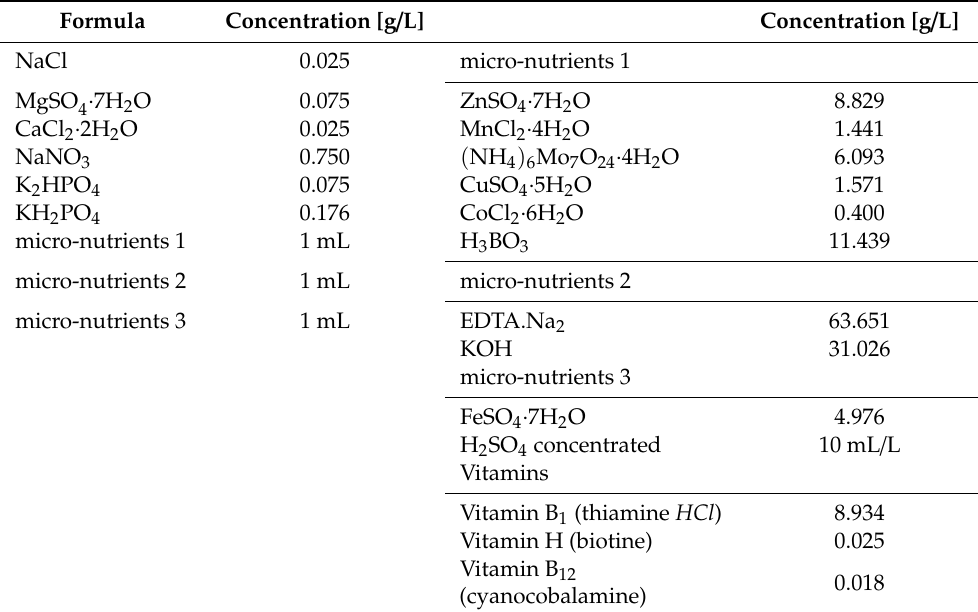
Table 1. Bold’s Basal Medium (BBM) modified